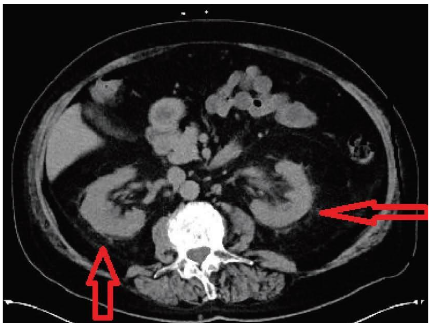
Figure 2: Computerized tomography of the abdomen and pelvis without contrast demonstrating bilateral perinephric stranding (red arrows), consistent with acute